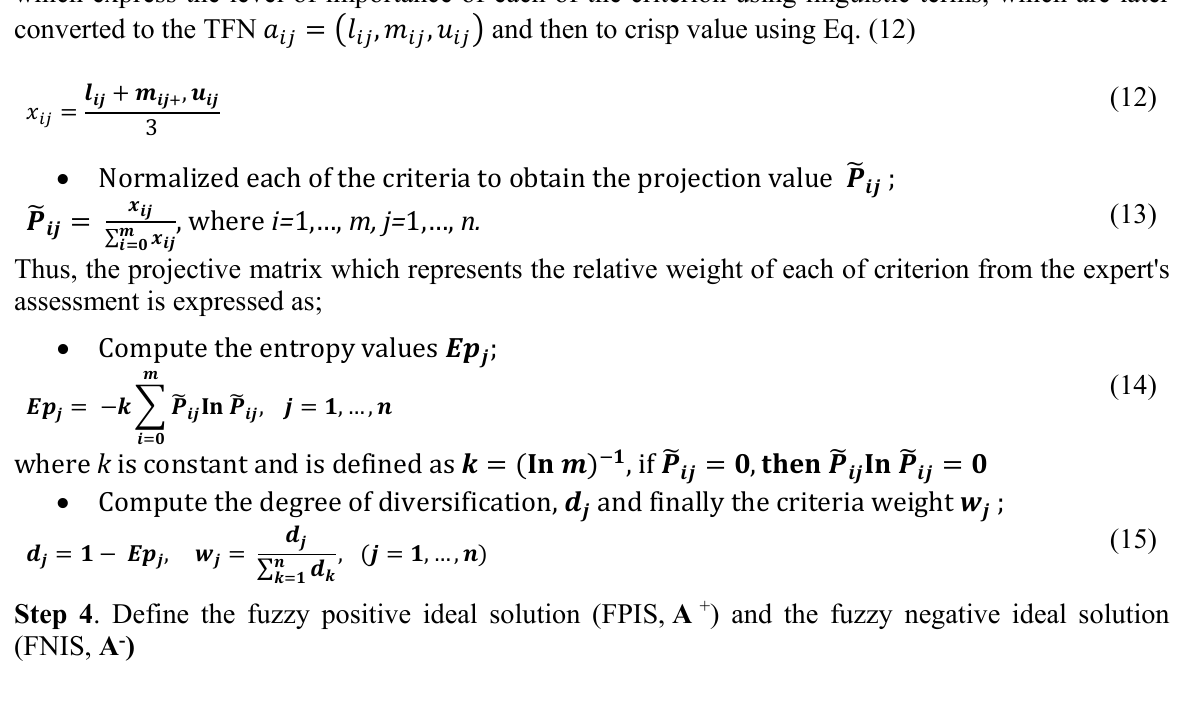
Fuzzy Shannon's entropy method based on ∝